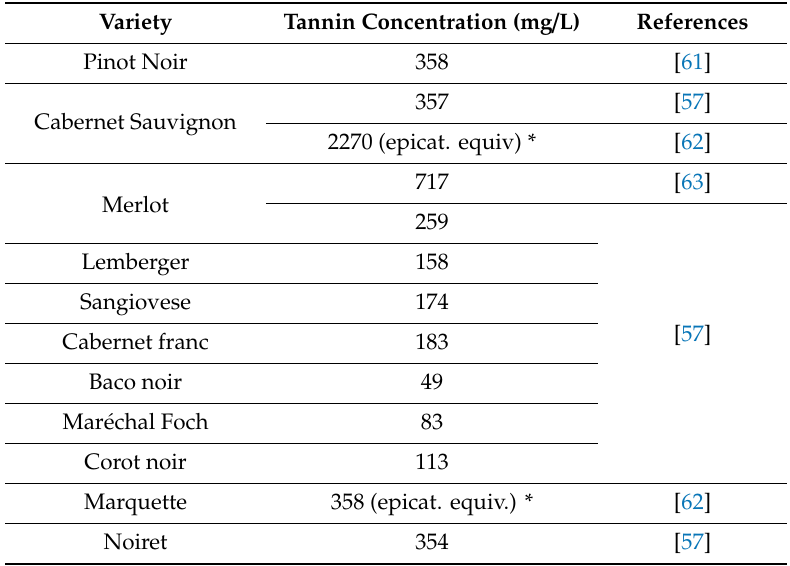
Table 3. Tannin concentrations measured by protein precipitation (or * methylcellulose precipitation) of wines made from Vitis vinifera and hybrid grape varieties.